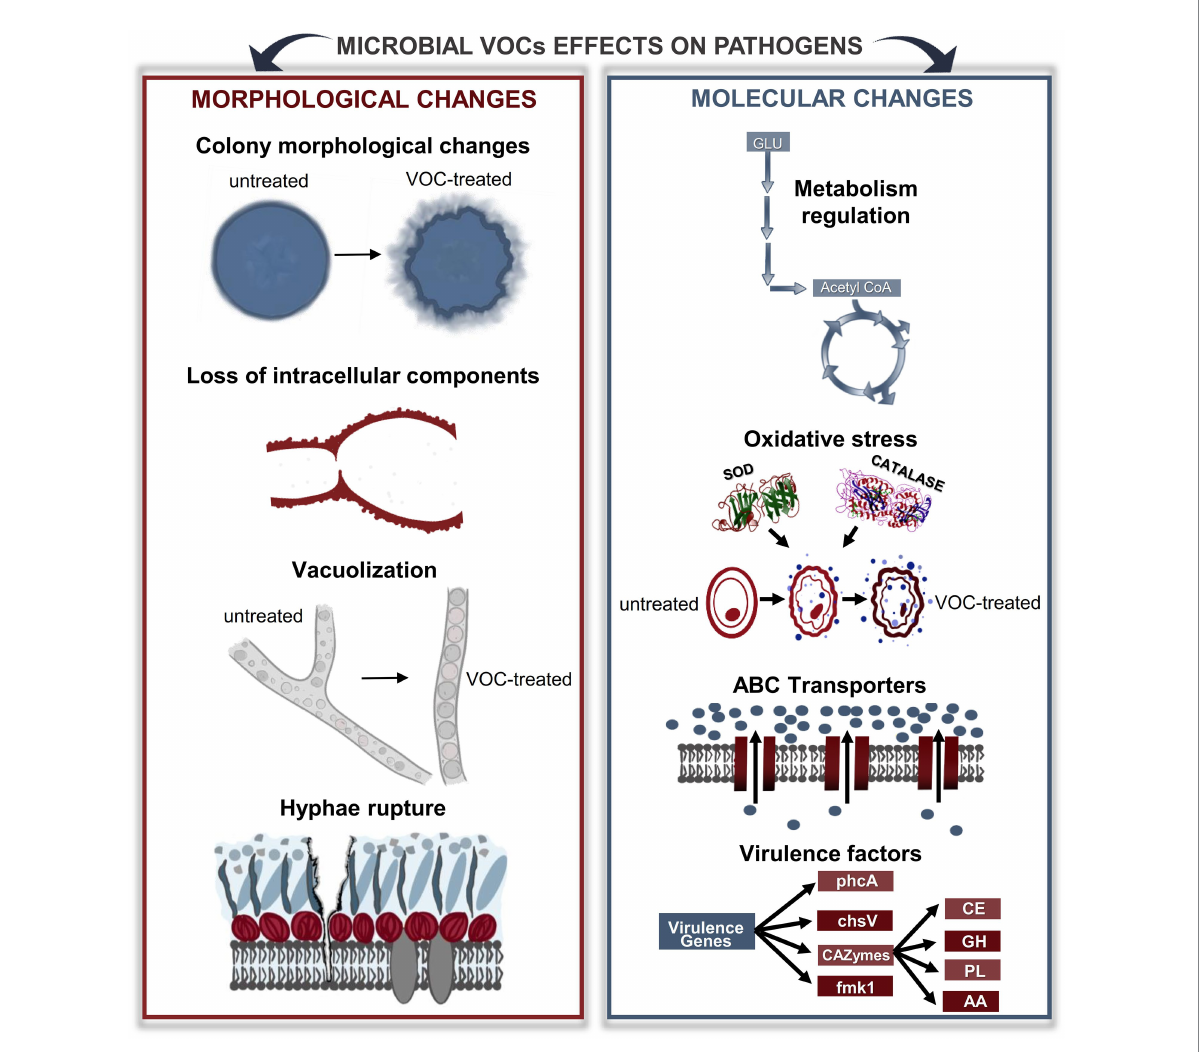
FIGURE 2 Microbial VOCs affect the morphology and physiology of phytopathogens. Through diverse approaches, it is possible to understand the changes that microbial VOCs cause in phytopathogens. Microscopy analyses revealed changes in the morphology of the colonies, loss of intracellular components, vacuolization, and cell rupture. In addition, omics-approaching studies have shown that many genes and proteins are up-and downregulated under the effects of VOCs, thus interfering with several important metabolic pathways, such as carbon metabolism and oxidative stress. GLU, glucose; SOD, superoxide dismutase; ABC, ATP-binding cassette; CAZymes, carbohydrate-activated enzymes; CE, carbohydrate esterases; GH, glycosyl hydrolases; PL, polysaccharide lyases; AA, auxiliary